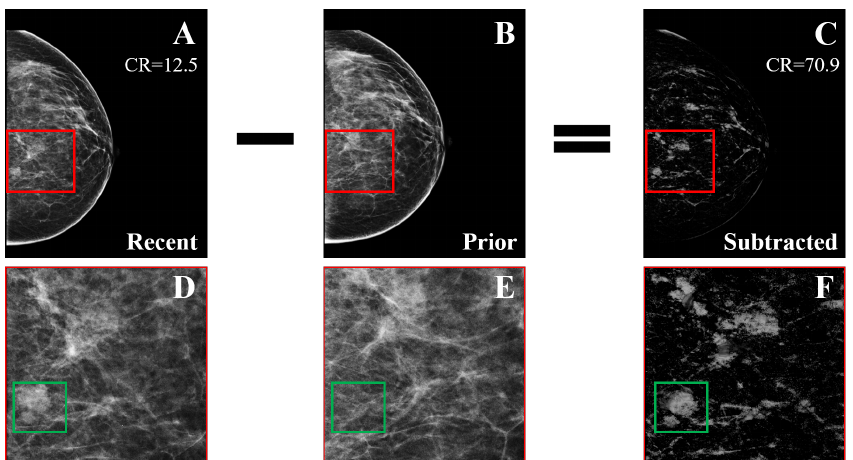
Figure 9. Example of temporal subtraction (BI-RADS breast density category c) with a malignant mass. ( A ) Most recent mammogram. ( B ) Prior mammogram. ( C ) The result of subtracting the registered version of ( B ) from ( A ). ( D – F ) Zoomed regions marked by the red squares in ( A – C ), respectively. The green squares enclose a new malignant mass that was not subtracted (reprint with permission from